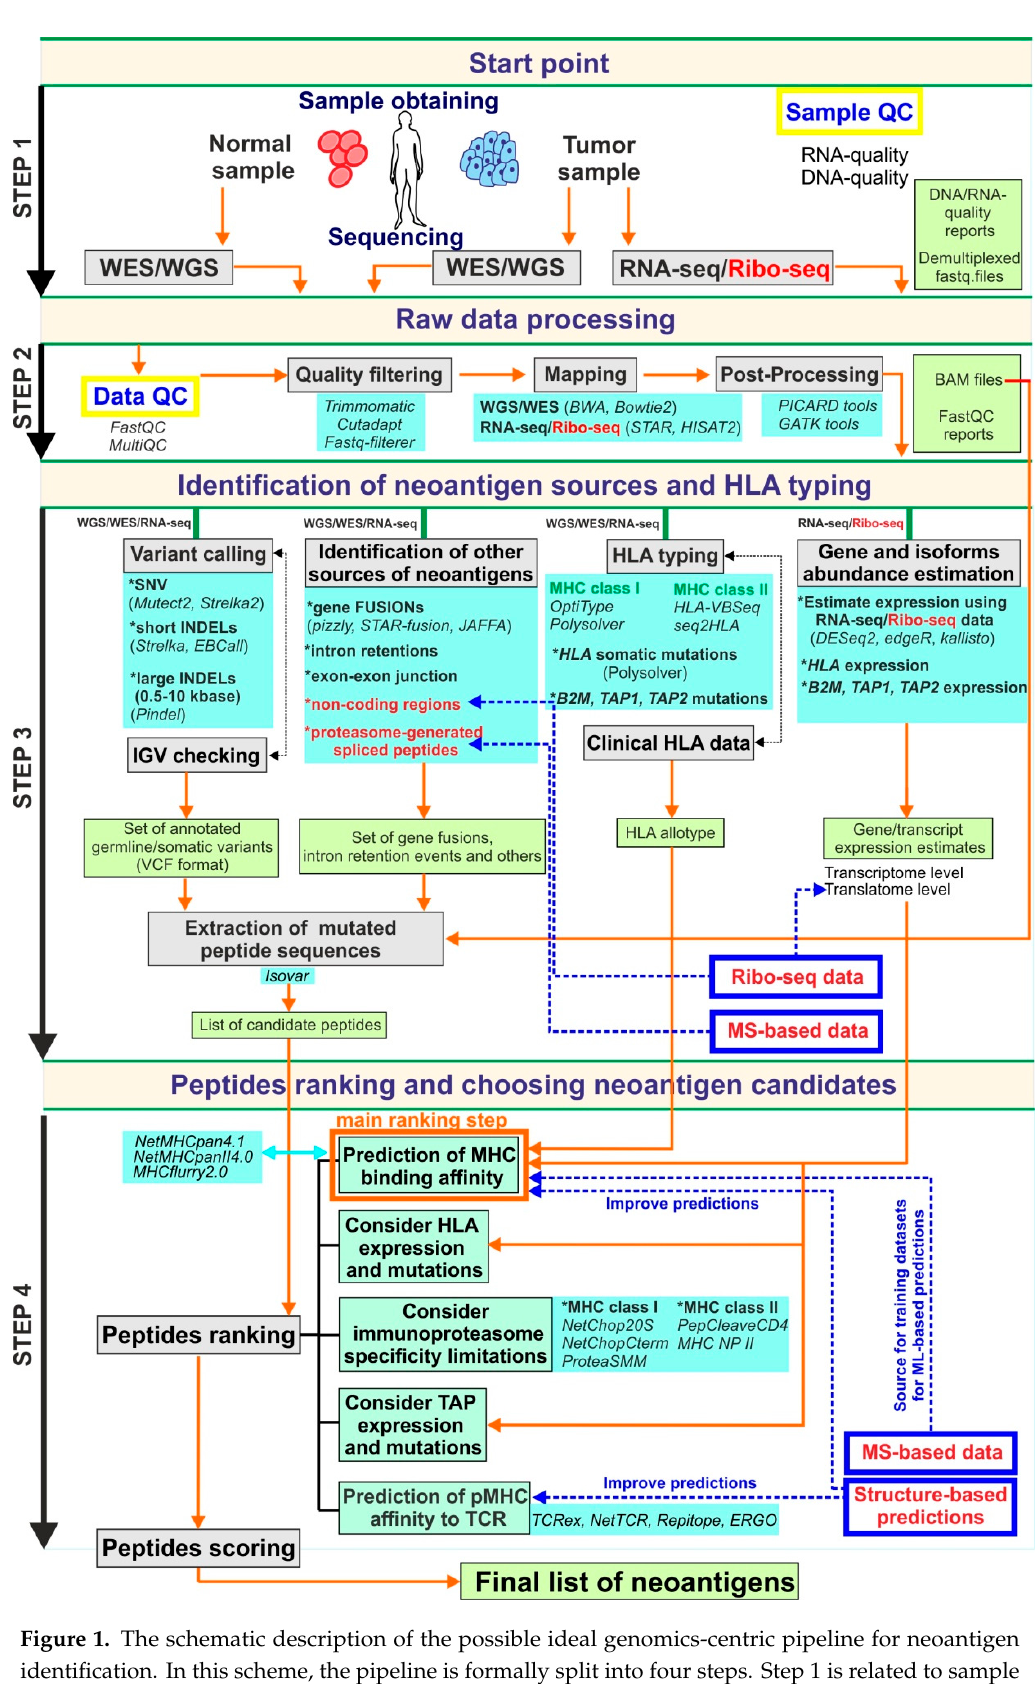
Figure 1. The schematic description of the possible ideal genomics-centric pipeline for neoantigen identification. In this scheme, the pipeline is formally split into four steps. Step 1 is related to sample obtaining, DNA/RNA-extraction, libraries preparation and high-throughput sequencing. Step 2 is associated with raw NGS data processing, quality-filtering and obtaining aligned to reference reads in an appropriate format suitable for downstream analysis. The aim of Step 3 is to obtain all possible information from processed NGS including all variants set, HLA allotype, expression estimations, as